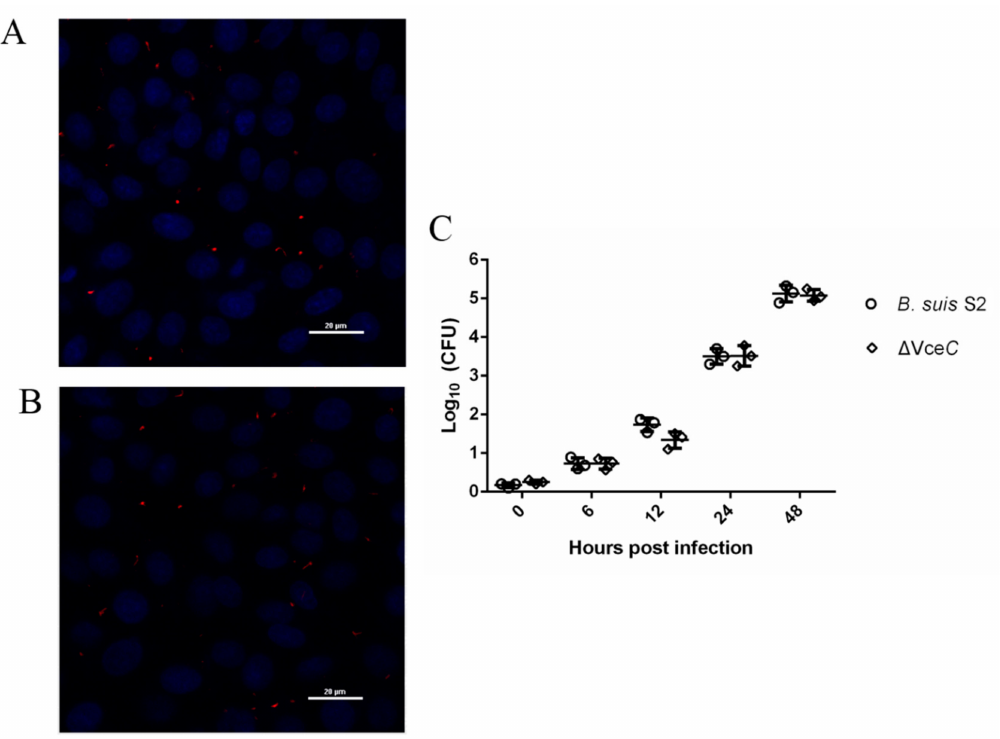
Figure 2. Infectionandproliferationof B.suis S2and ∆ VceCingoattrophoblastcells(GTCs). ( A , B )Representative confocal micrographs of GTCs infected with B. suis S2 ( A , red) and ∆ VceC ( B , red) at 24 h post infection. The data shown are representative of three independent experiments. ( C ) Intracellular survival in GTCs of wild type ( B. suis S2, circle) and the mutant obtained ( ∆ VceC, square). The results are expressed as the means ± standard deviation from three independent experiments at each time